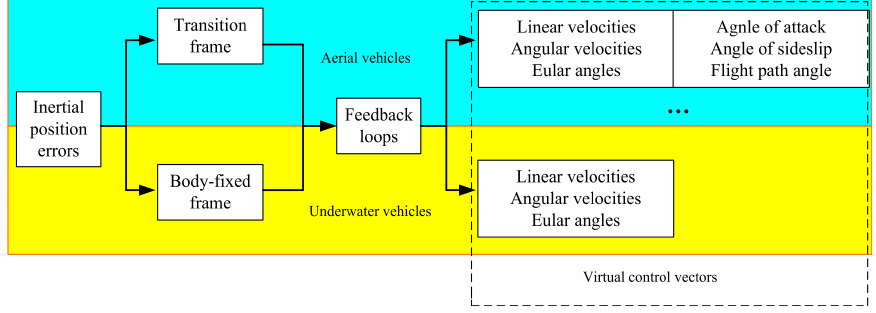
Figure 5. The Lyapunov-based backstepping method for AUVs and